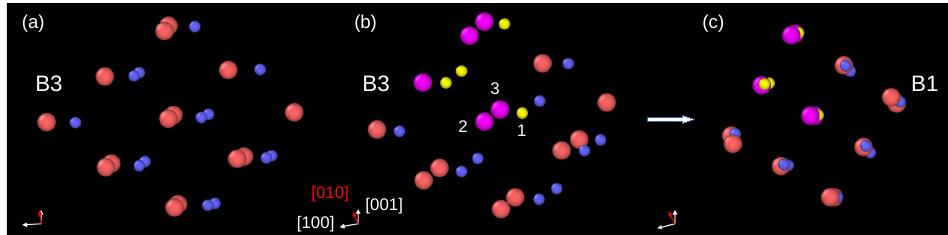
Figure 3. Details of the B3 → B1 phase transformation. ( a ) Group of atoms in the B3 phase right before the phase transformation viewed along the [0–11] direction. ( b ) The same group of atoms; however, the direction of view was slightly changed for a better presentation of further atom displacements. Several atoms are colored: the P atoms—yellow, In atoms—magenta. ( c ) After the phase transforma- tion, the atoms form the B1 unit cell. The orthorhombic pathway of the phase transformation can be traced using atoms marked as 1, 2, and 3. The atom 1 (P) displaces into the site between its nearest neighbors 2 (In) and 3